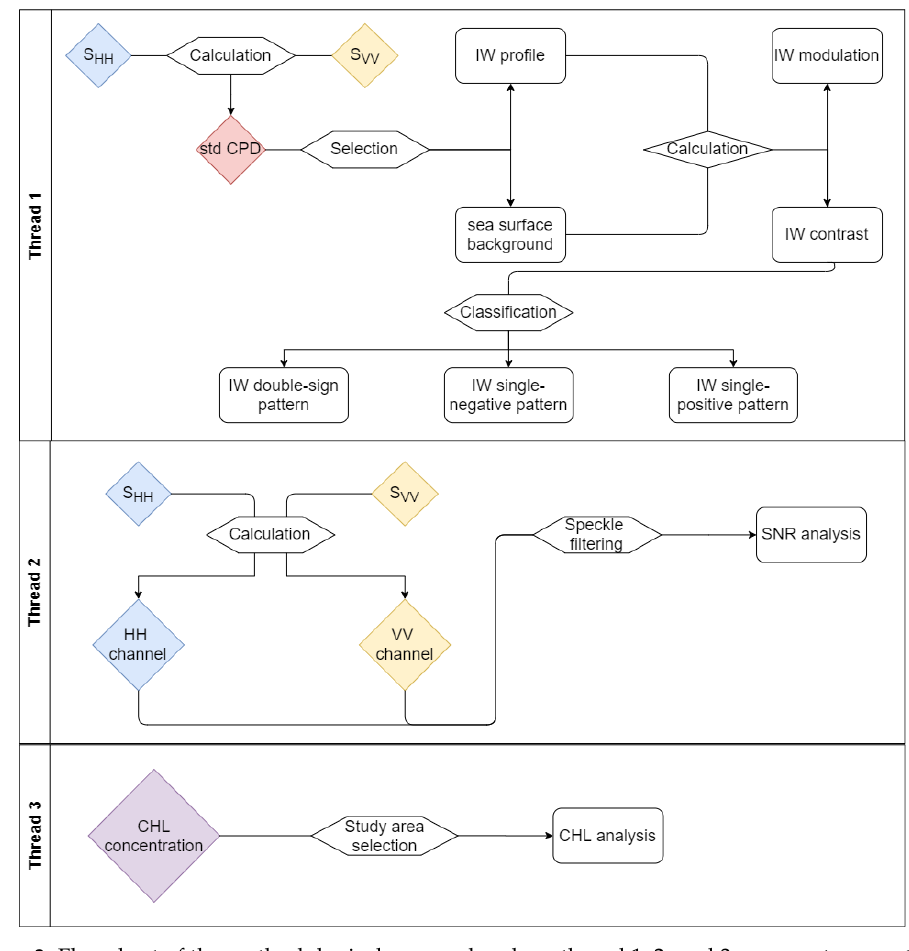
Figure 3. Flowchart of the methodological approach, where thread 1, 2, and 3 represent, respectively, the analysis of the IW contrast profiles according to the IW signature type, the analysis of the signal to noise ratio (SNR), and the investigation of the chlorophyll-a concentration maps associated to each SAR image of our data set.